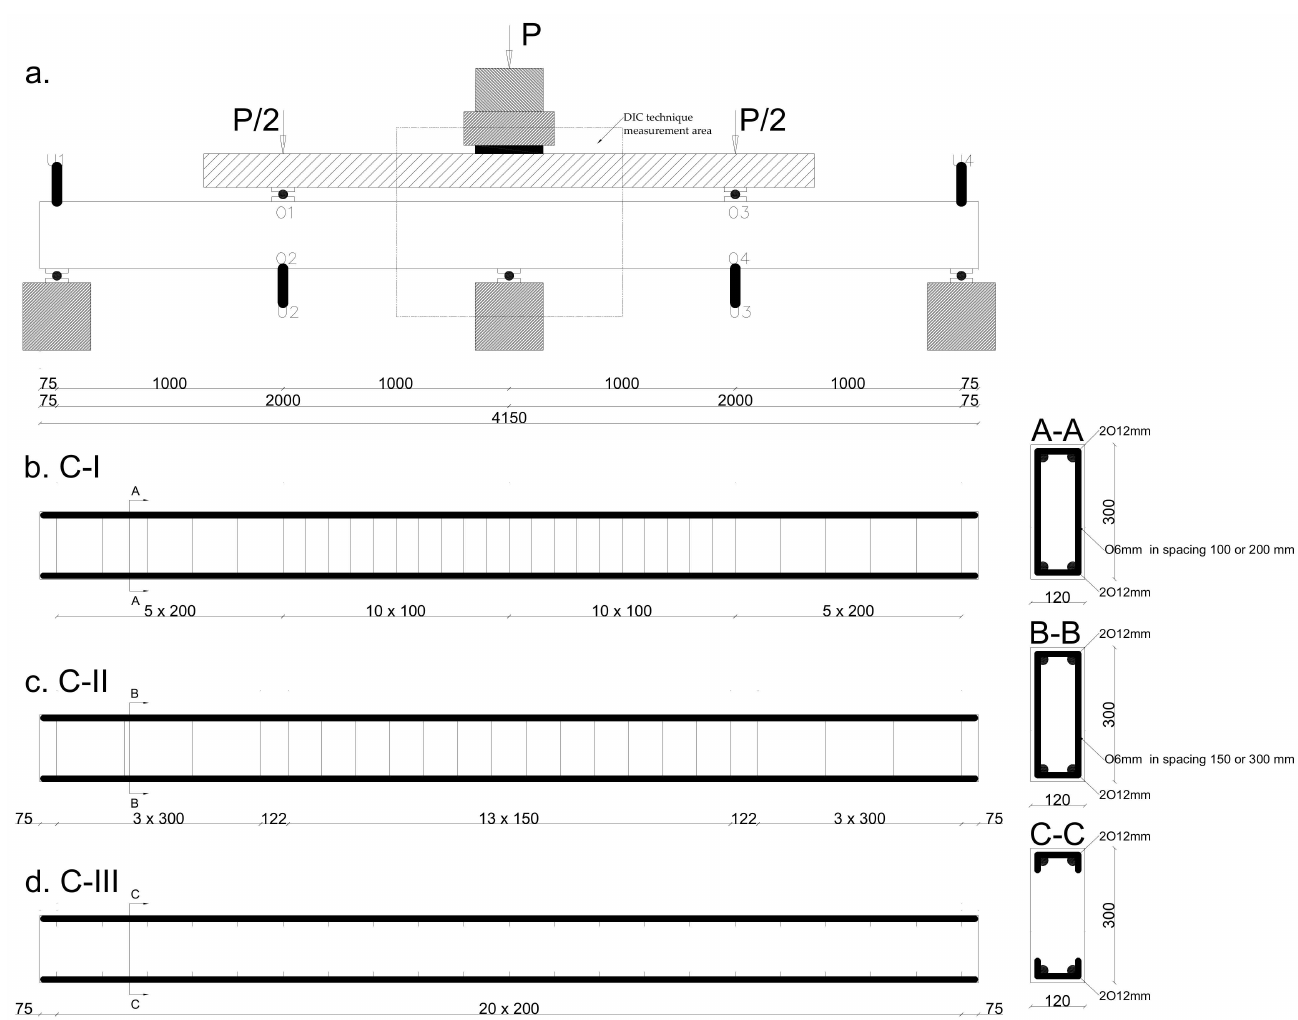
Figure 3. Beam specimen in series ( a ) diagram of measurement points ( b ) C-I, ( c ) C-II, and ( d ) C-III. In each beam series, the proportion of longitudinal reinforcement was ρ e =